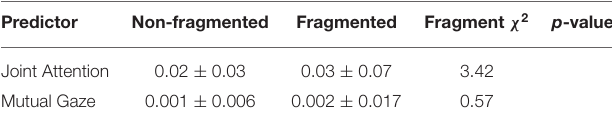
TABLE 2 | LMM on group attention features in Fragment (NoF-F) fixed